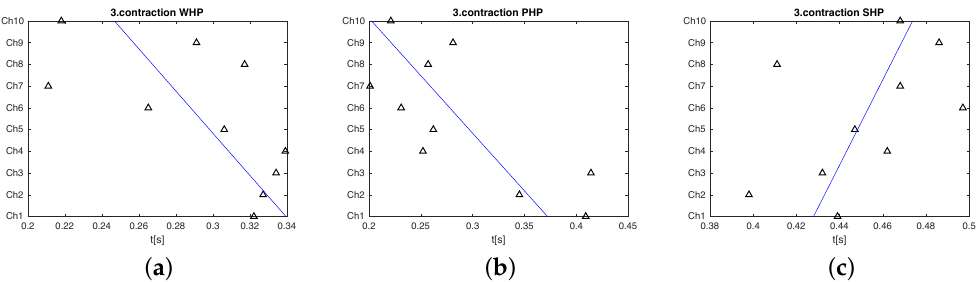
Figure 4. Example of start position of third contraction on the channel (Ch1-Ch10) and approximation curve. ( a ) Start of contraction without using heel pad (WHP), ( b ) start of contraction with pronation heel pad (PHP), ( c ) start of contraction with supination heel pad (SHP).